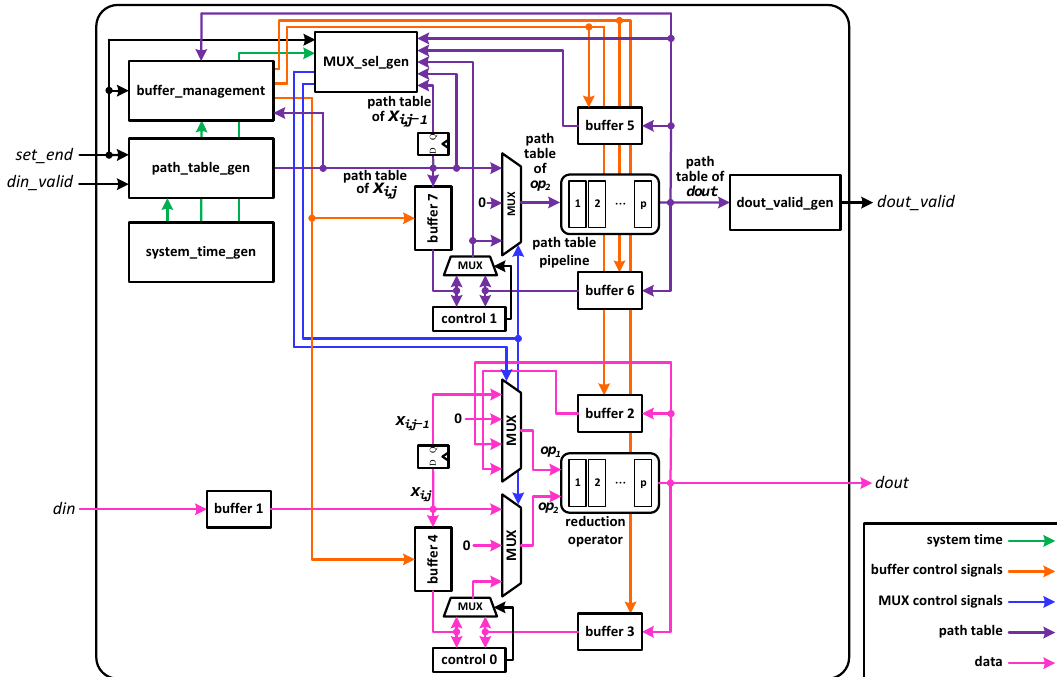
Figure 7. The hardware structure of